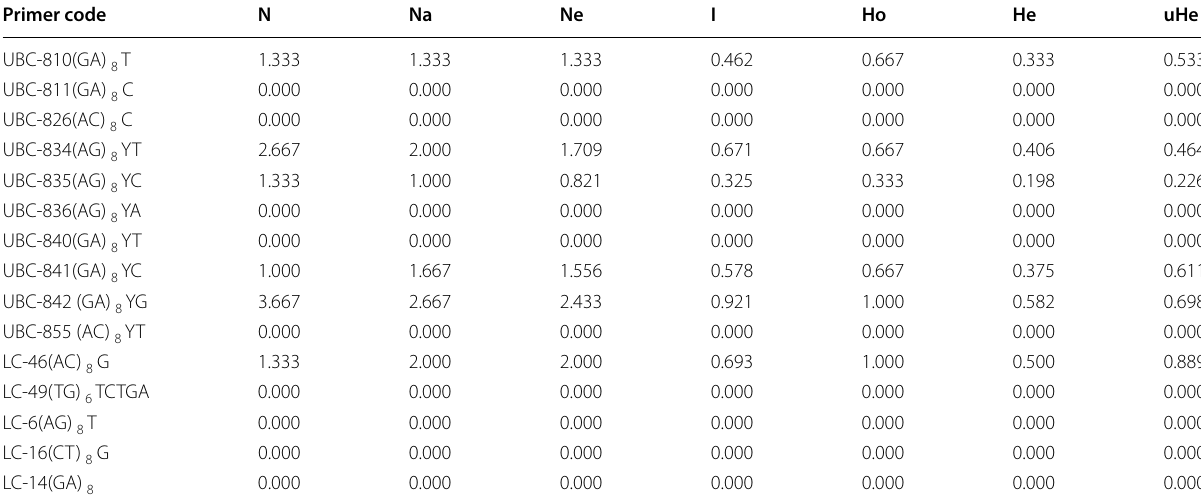
Na no. of different alleles, Ne no. of effective alleles, I Shannon’s information index, Ho observed heterozygosity, He expected heterozygosity, uHe unbiased expected heterozygosity